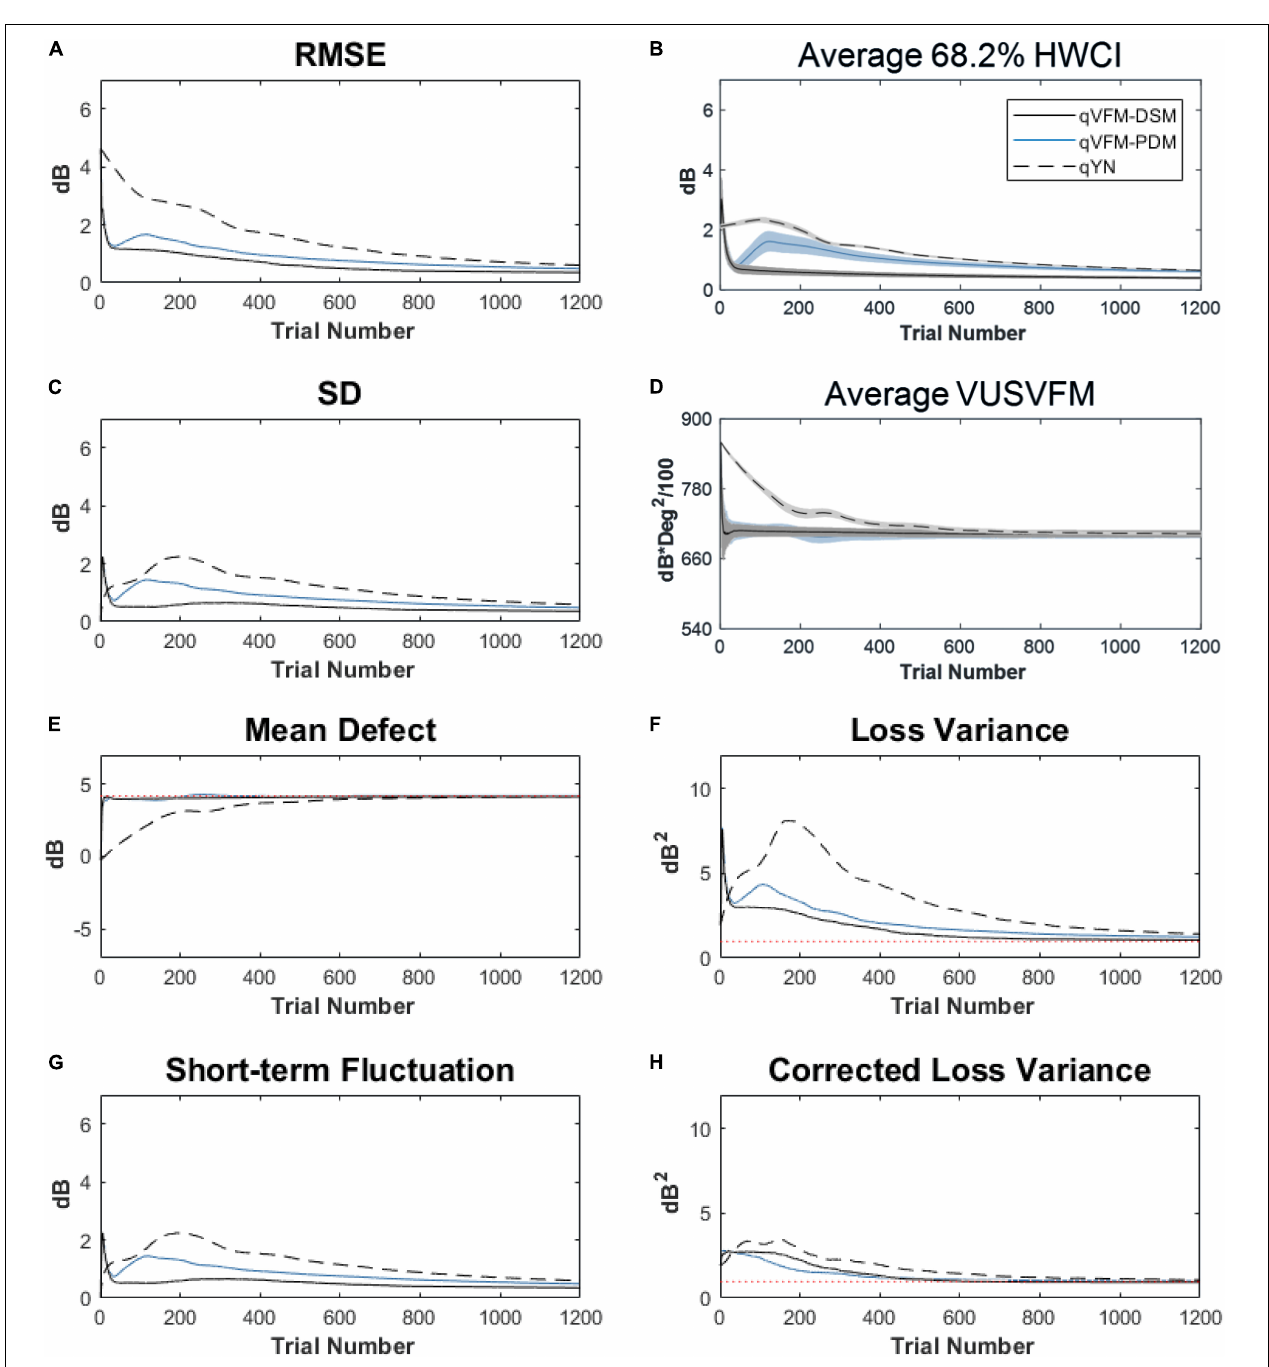
FIGURE 12 | Performance I of the three methods in estimating VFM of the simulated cataract observer across 200 runs. (A) Average root mean squared error, (B) Average 68.2% HWCI of the estimated VFM, (C) Average standard deviation, (D) Average volume under the surface of the VFM (VUSVFM), (E) Mean defect, (F) Short-term fluctuation, (G) Loss variance, and (H) Corrected loss variance. Results from the qVFM-DSM and qVFM-PDM methods are shown in solid black and blue lines, and results from the qYN method are shown in dashed lines. The true values of the global indices are shown in red dotted lines. For panels (B,D) , shaded regions represent ± 1 SD of the corresponding